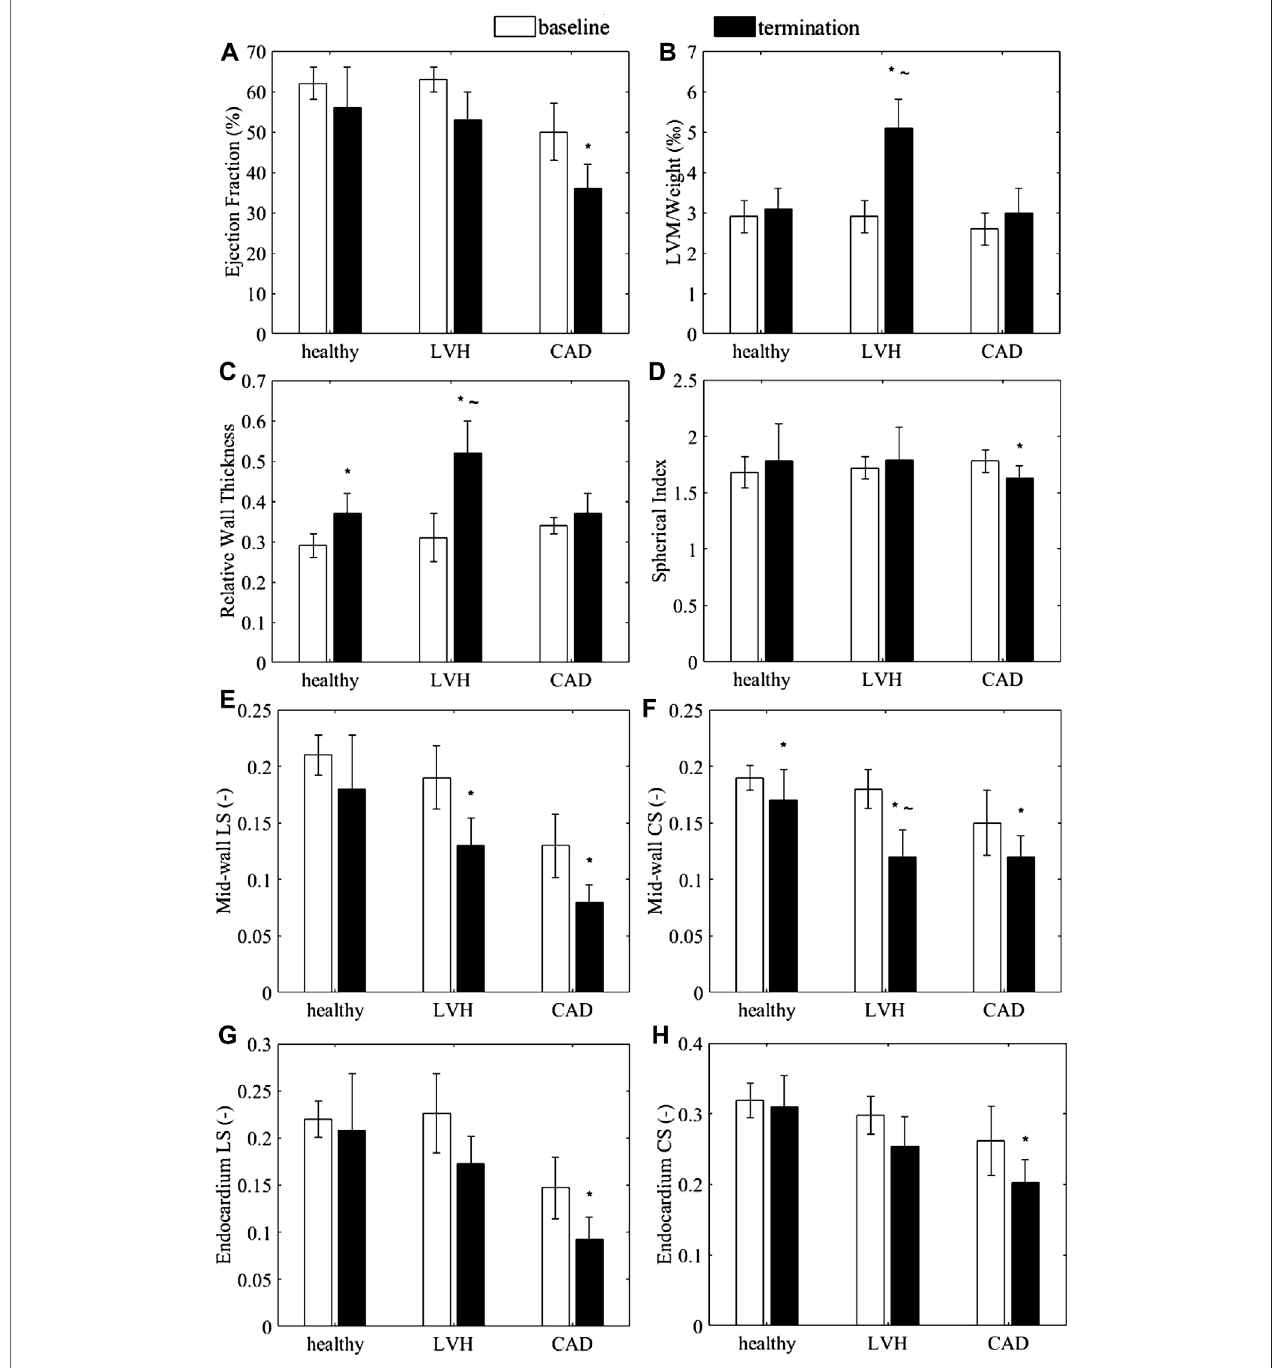
FIGURE 2 | (A – D) Anatomic and functionalcharacteristics of the porcine animal models, (A) Endocardial ejection fraction (B) LVM normalized by body weight, (C) relative wallthickness,and (D) sphericalindex. (E – H) Myocardialstrainsexhibitedbytheanimalsubjects. (E,G) Globallongitudinalstrainand (F,H) globalcircumferentialstrainat (E,F) the mid-wall and (G,H) the endocardium, measured from the healthy (sham), LVH and CAD porcine CMRI. * p < 0.05 with baseline. ~ p < 0.05 with healthy for LVH only.